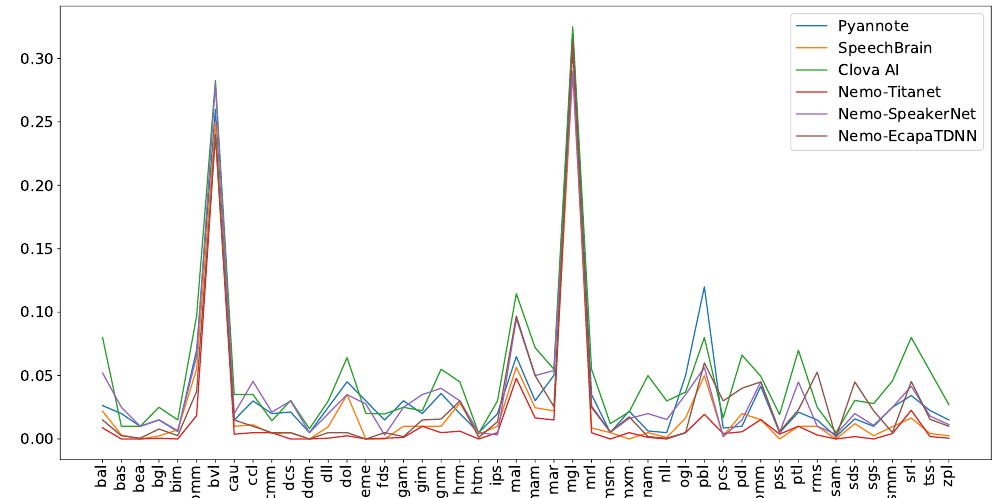
Figure 1. EER values for the individual speakers across the embedding architectures.